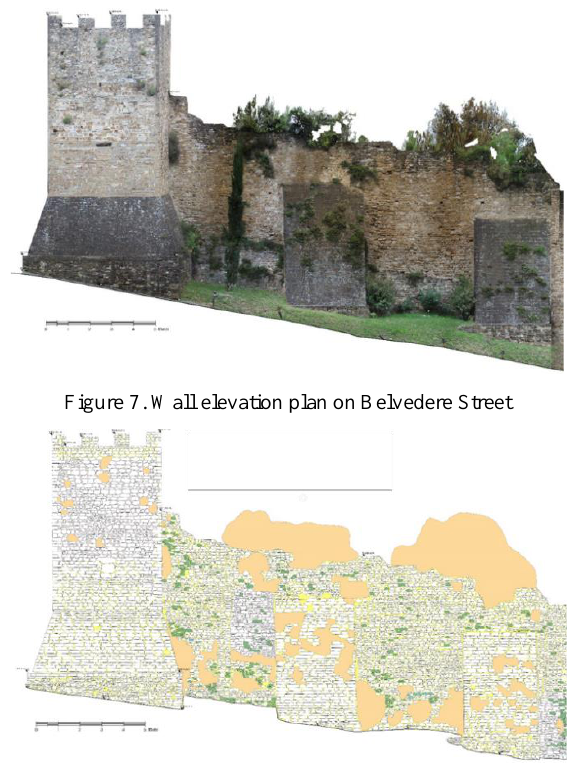
Figure 8. Wall elevation plan on Belvedere Street – Materials: In white the Pietra Forte, in Green the Pietra Alberese, in Yellow the lime mortar, in Light blue the Pietra serena, in Grey the cement mortar, in Orange the Vegetation.